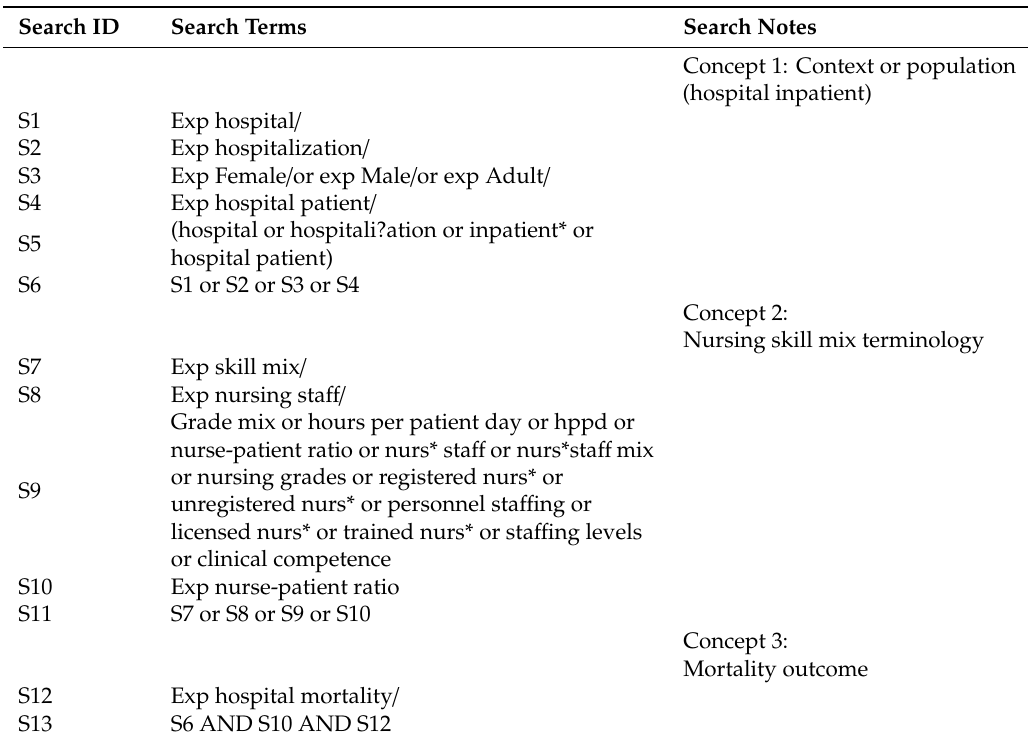
Table 1. Medline